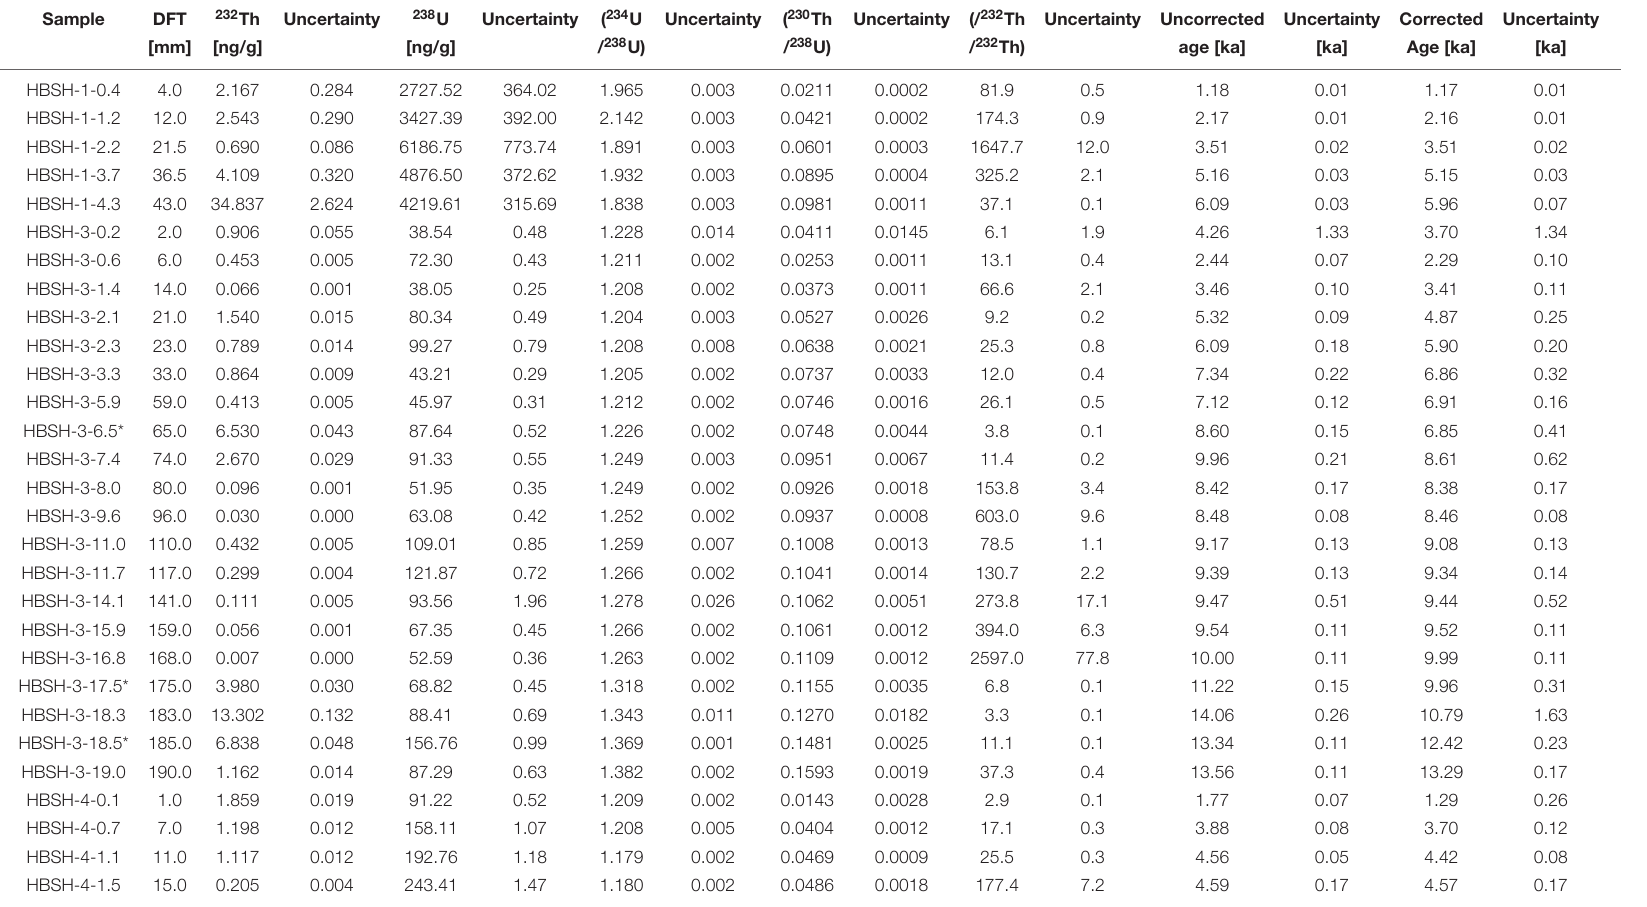
TABLE 1 | Uranium and Th concentrations, activity ratios and 230 Th/U-ages for the Holocene stalagmites from HBSH. All uncertainties are quoted as 2 SE. All activity ratios and ages were corrected for detrital contamination assuming a 232 Th/ 238 U mass ratio of 3.8 ± 1.9, calculated from the average Th and U concentrations of tonalities which are believed to be representative for the bulk continental crust (Wedepohl, 1995). 230 Th, 234 U, and 238 U were assumed to be in secular equilibrium for the detritus. Activity ratios were calculated using the half-lives from Cheng et al. (2000). All measurements highlighted with an asterisk were measured at the Institute for Geosciences with a Neptune Plus MC-ICP-MS. Sample HBSH-1 was analyzed at the BIG. BDL = below detection limit; NA = not available due to 232 Th concentration below detection limit. All ages are given relative to the year AD